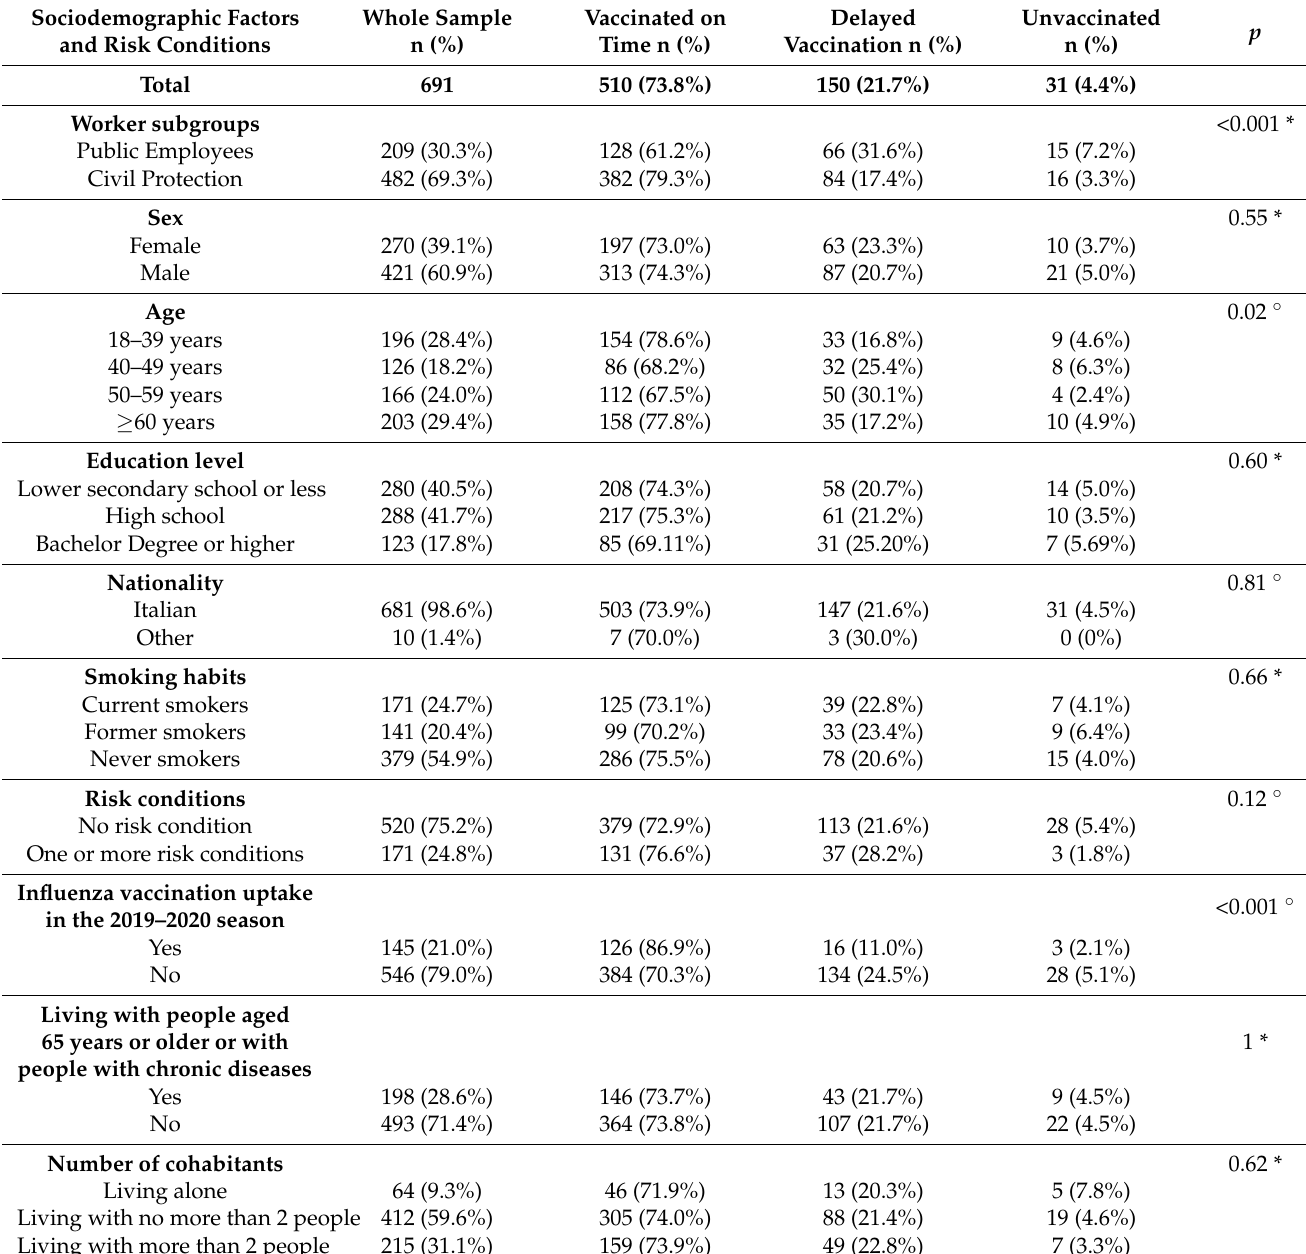
Table 2. Sociodemographic factors and risk conditions of the whole sample and of the three vaccina- tion subgroups (vaccinated on time, delayed vaccination, and